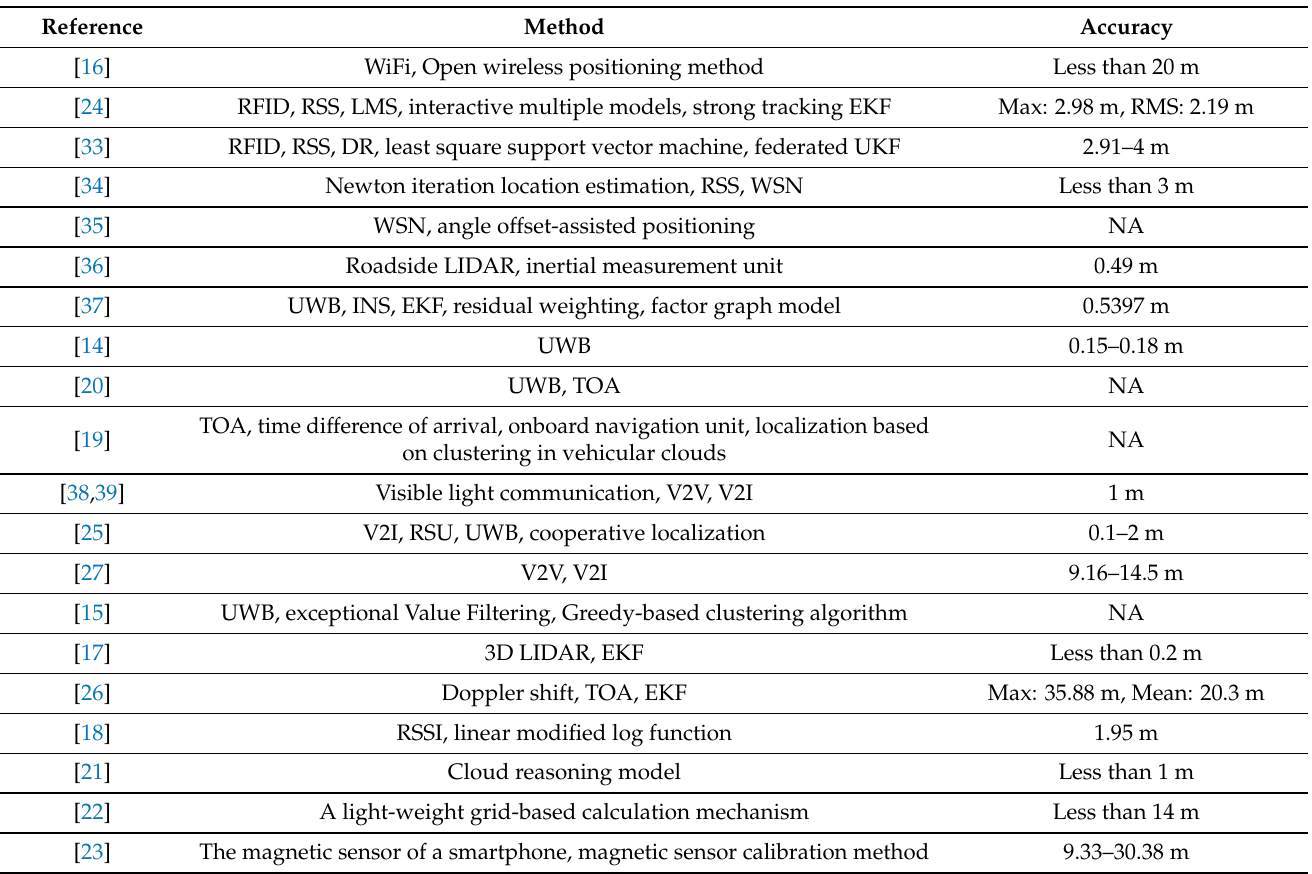
Table 1. Vehicle localization methods in tunnel